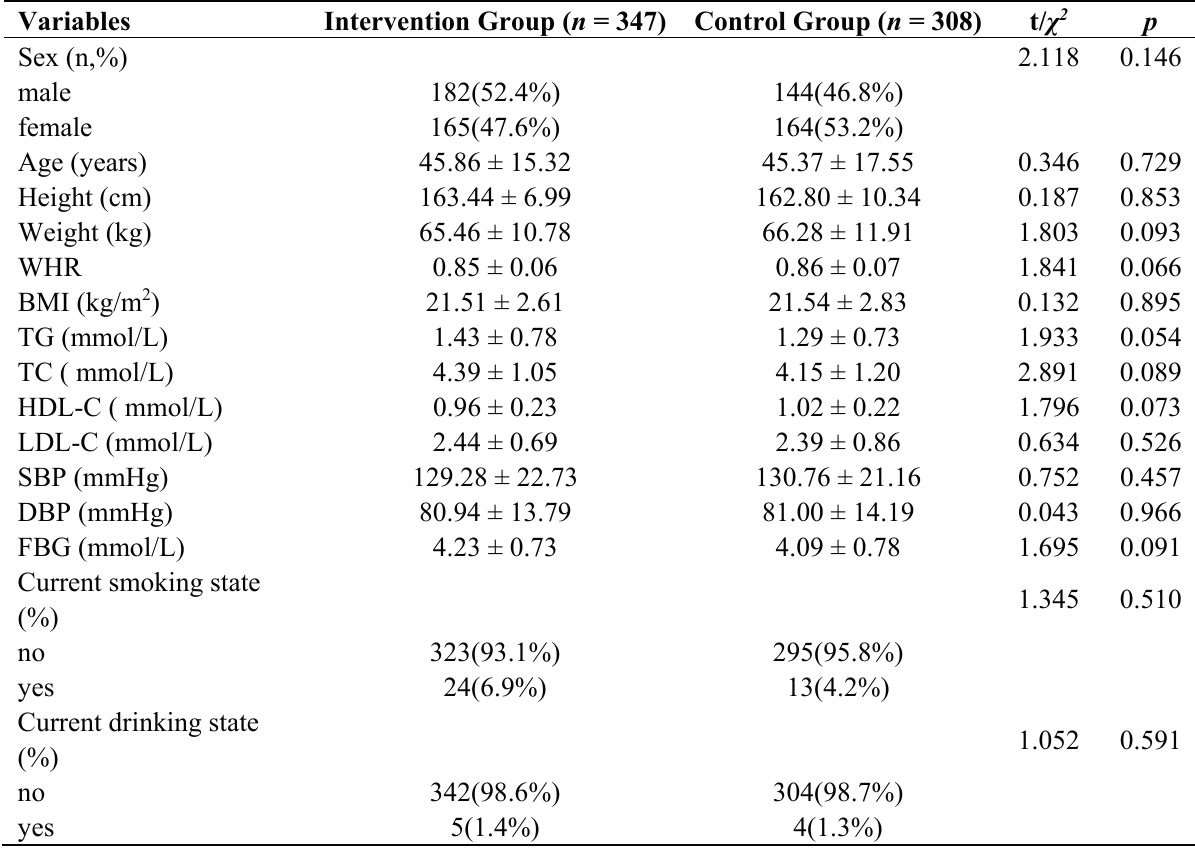
Table 1. Basic characteristics of the study population at baseline.